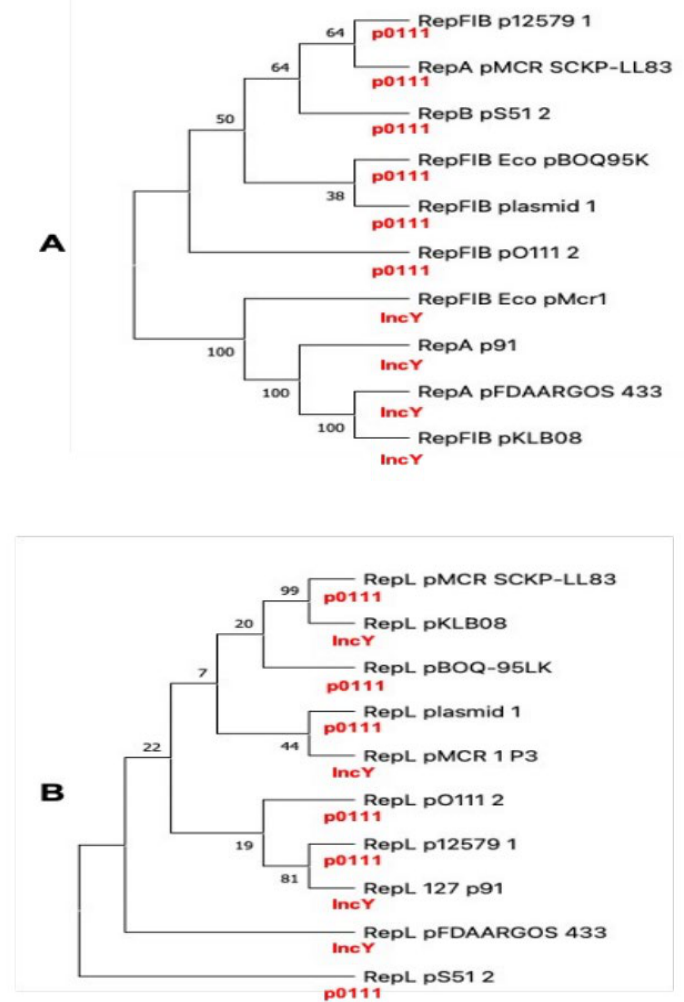
Figure 5. Phylogenetic tree using RepFIIB (replication origin, ( A ) and RepL (a protein involved in replication, ( B ), using UPGMA algorithm in MEGA software with a 1000 bootstrapping value).